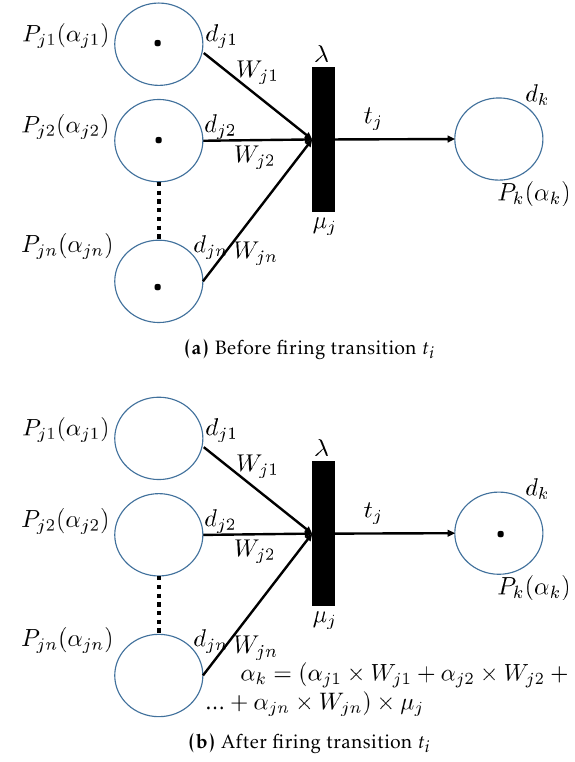
Figure 2. Fuzzy petri nets representation of type 1